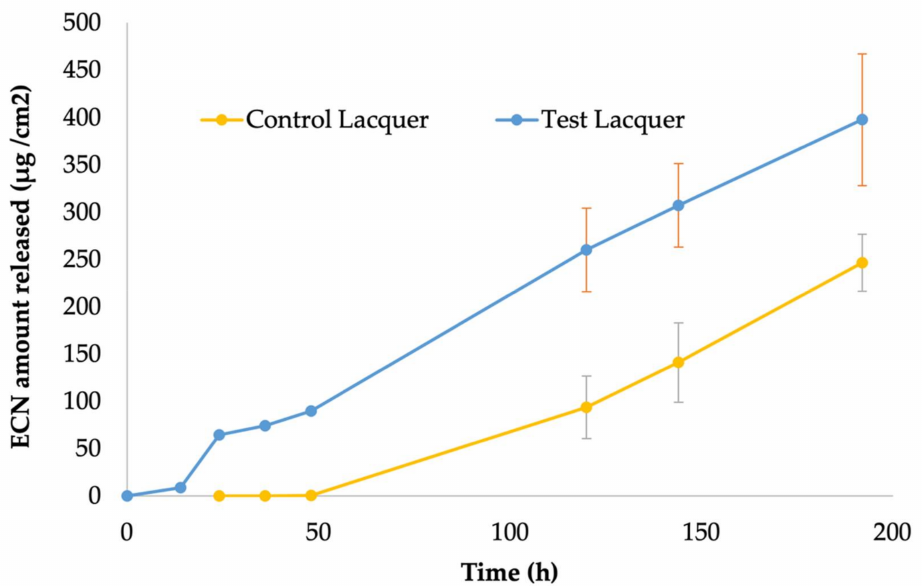
Figure 4. Ex vivo nail permeation study showing cumulative amount of econazole nitrate permeated though a unit area of human cadaver nails from topically applied test and control nail lacquers, reported as mean ± SD; n = 5 for test lacquer, and n = 3 for control